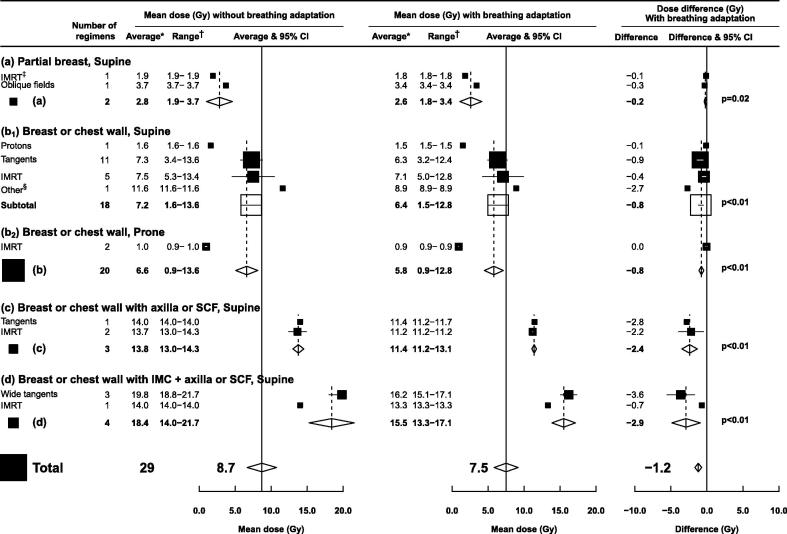
Mean ipsilateral lung doses (MLDipsi) from left or right breast cancer radiotherapy with or without breathing adaptation according to regions irradiated and regimens used. Only studies providing doses with and without breathing adaptation in the same woman were included. Studies of women with unfavourable anatomy were excluded. *Average of mean ipsilateral lung doses for reported regimens. †Range of mean ipsilateral lung doses for reported regimens. ‡Static field IMRT and rotational IMRT are included jointly as “IMRT”. § “Other” includes one unspecified 3D conformal regimen. p values are calculated using a paired t-test. Abbreviations: CI: confidence interval; IMRT: intensity modulated radiotherapy; IMC: internal mammary chain; SCF: supraclavicular fossa.